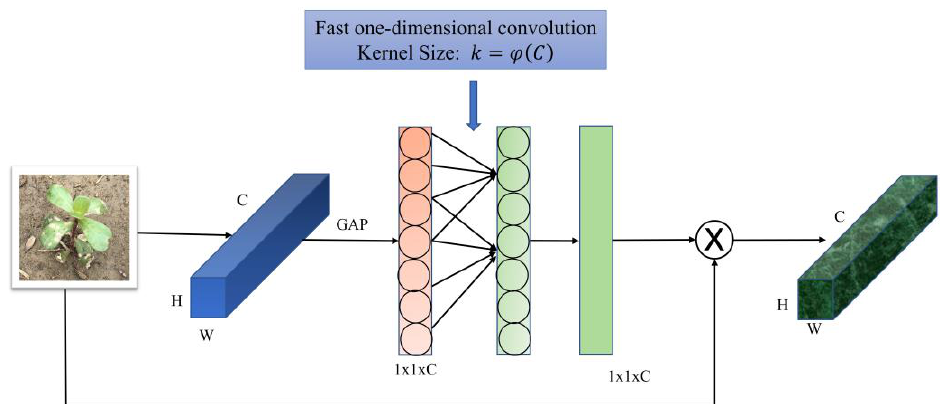
Figure A1. ECA network structure, where C is the channel dimension of the input data, H is the height of the input data, and W is the width of the input data. GAP denotes global average pooling, and k denotes the size of the convolution kernel using fast one-dimensional convolution.